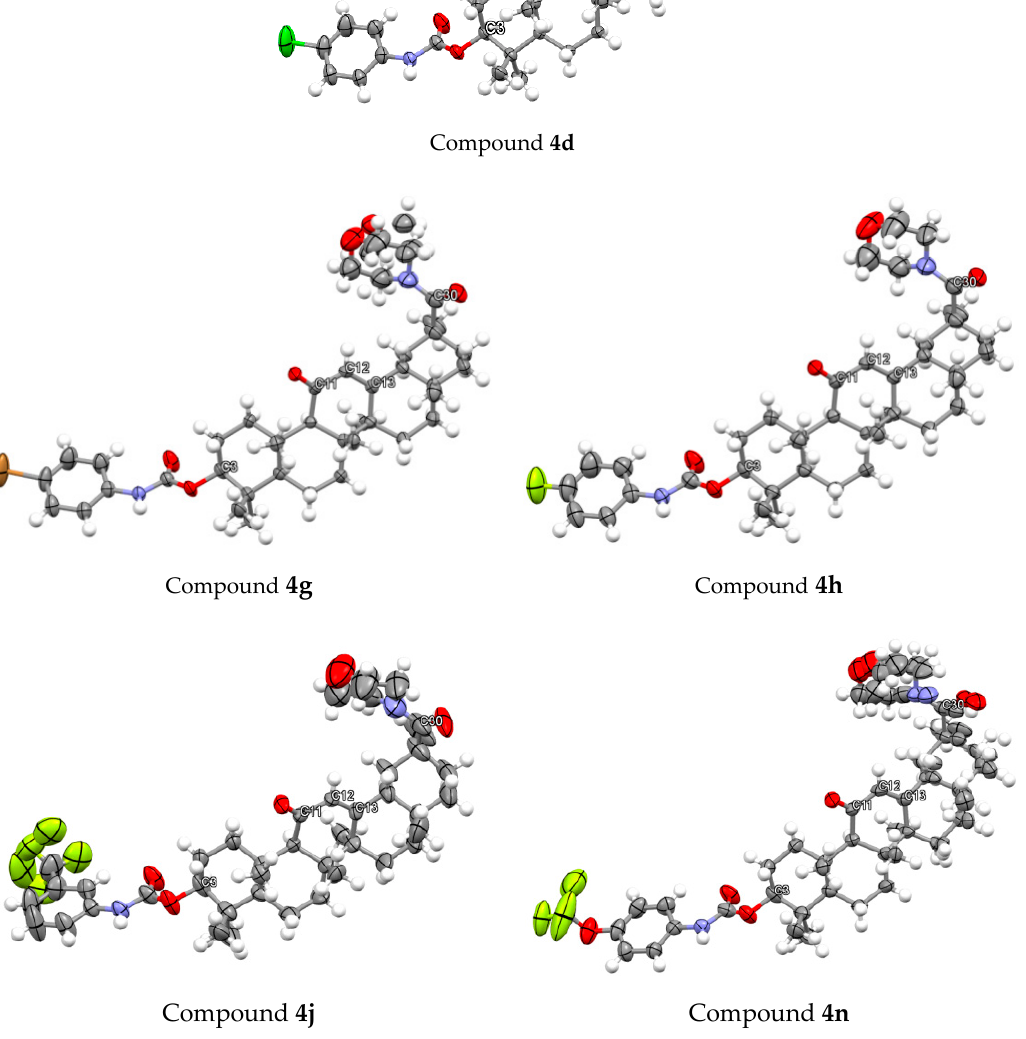
Figure 4. ORTEP diagram of compounds 4d , 4g , 4h , 4j , and 4n at 50% probability.